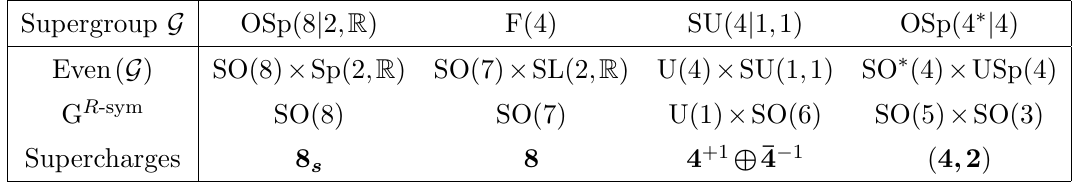
Table 1. Supergroups with SL(2 ; R ) factor and eight supercharges [22, 23]. We also list their G even part G even SL(2 ; R ) G R -sym and their R -symmetry group G R -sym . The supercharges are ’ (cid:2) given in representations of G R -sym